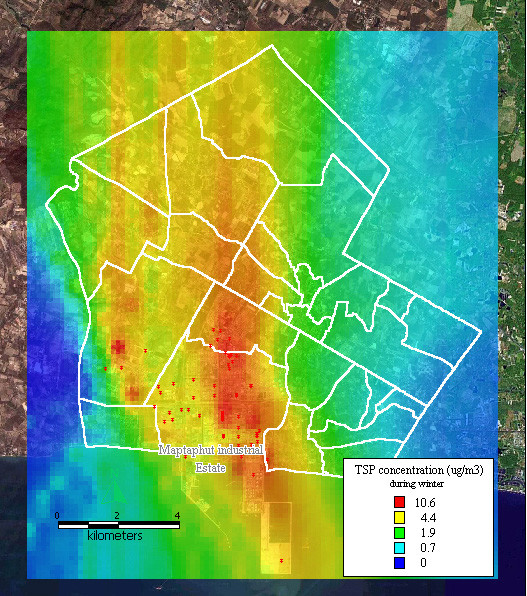
Dispersion of TSP during winter. Red dots indicate the stacks that released total suspended particle.